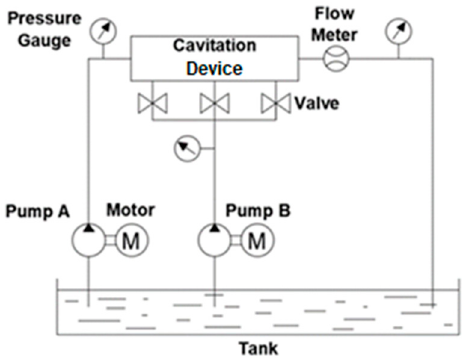
Figure 9. Hydraulic circuit of the overall system.